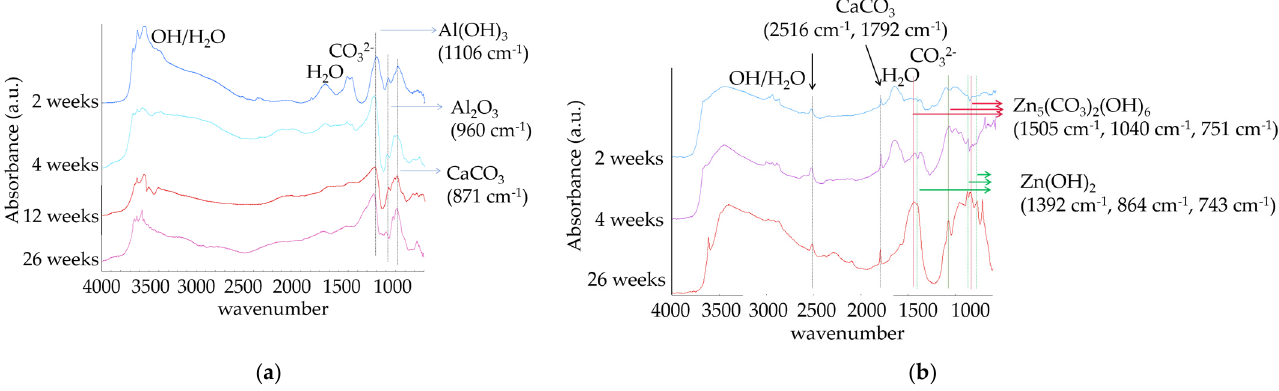
Figure 8. FTIR spectra generated for ( a ) Al and ( b ) Zn embedded in concrete immersed in AGW at anaerobic conditions for 2, 4, 12 and 26 weeks.